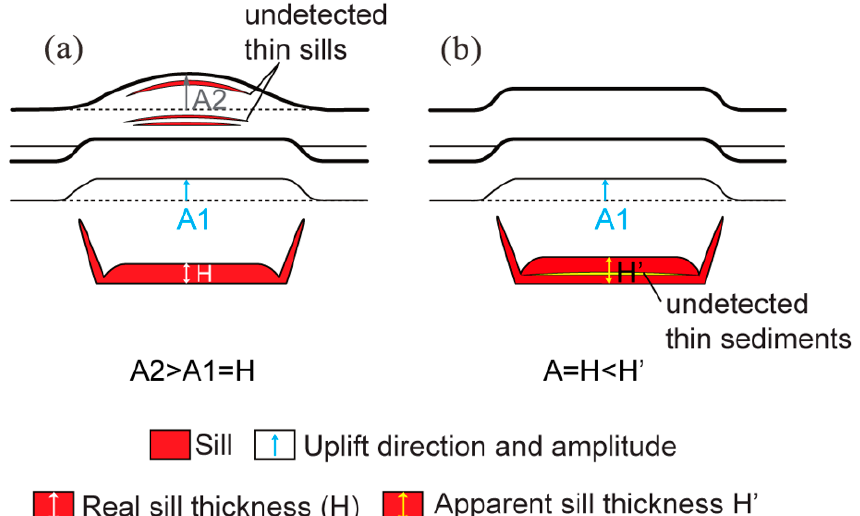
Figure 8. Models showing how the ratio of fold amplitude (A) and sill thickness (H sill ) is overesti- mated or underestimated (modified after ref. [11]). ( a ) Schematic showing how the occurrence of seismically undetected, thin sills within the fold could produce the observed upward increase in fold amplitude, and the observed A2/H would be >1, which is larger than the real A/H sill ; ( b ) Schematic showing how the occurrence of seismically undetected, thin sedimentary layers within sills lead to overestimation of sill thickness, and the observed A/H’ would be <1, which is smaller than the real A/H sill .